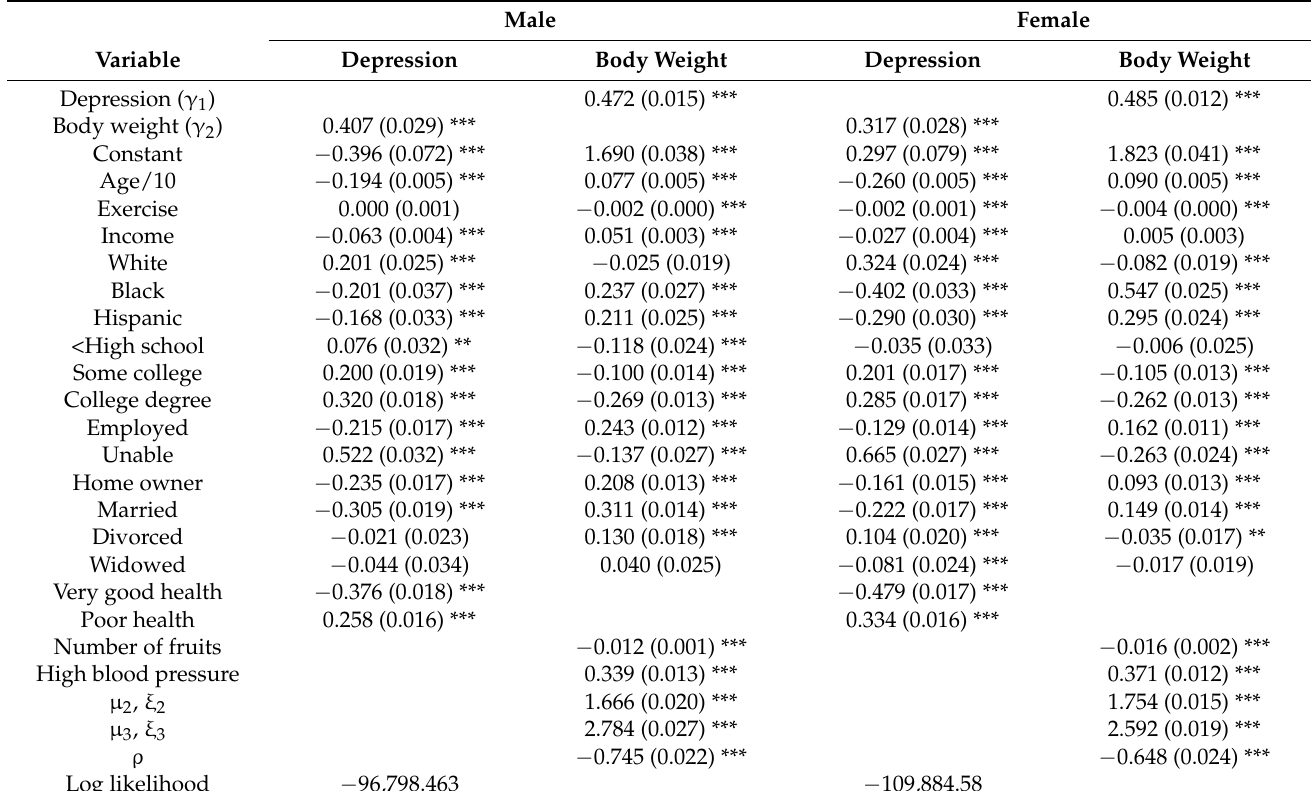
Table A2. Full information on the maximum-likelihood estimation of the simultaneous equation